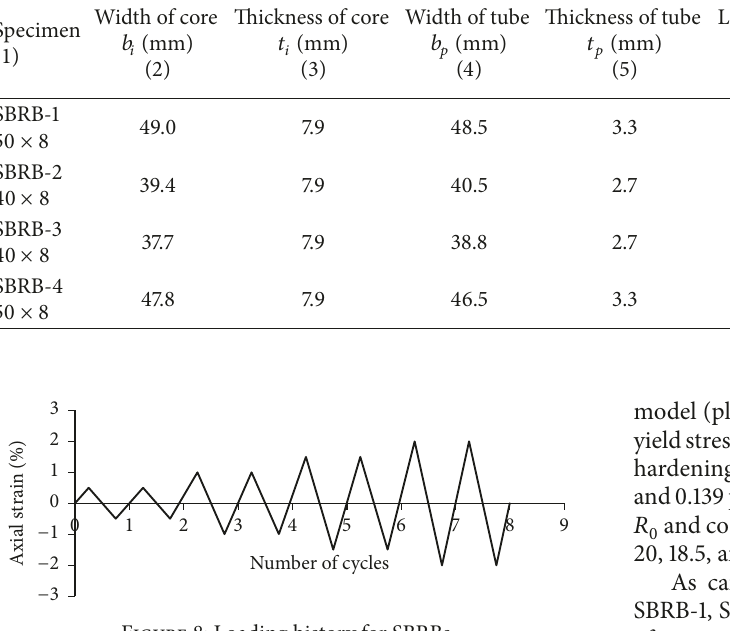
Figure 8: Loading history for SBRBs. Table 2: Properties of SBRB